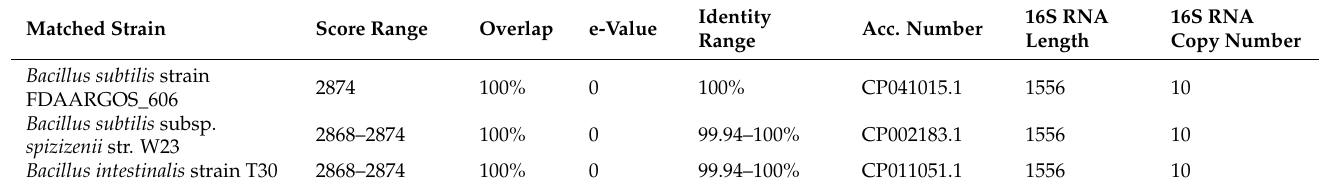
Table 2. B. subtilis subsp. spizizenii MC6B-22 genome characteristics compared with the top three hits. Matched